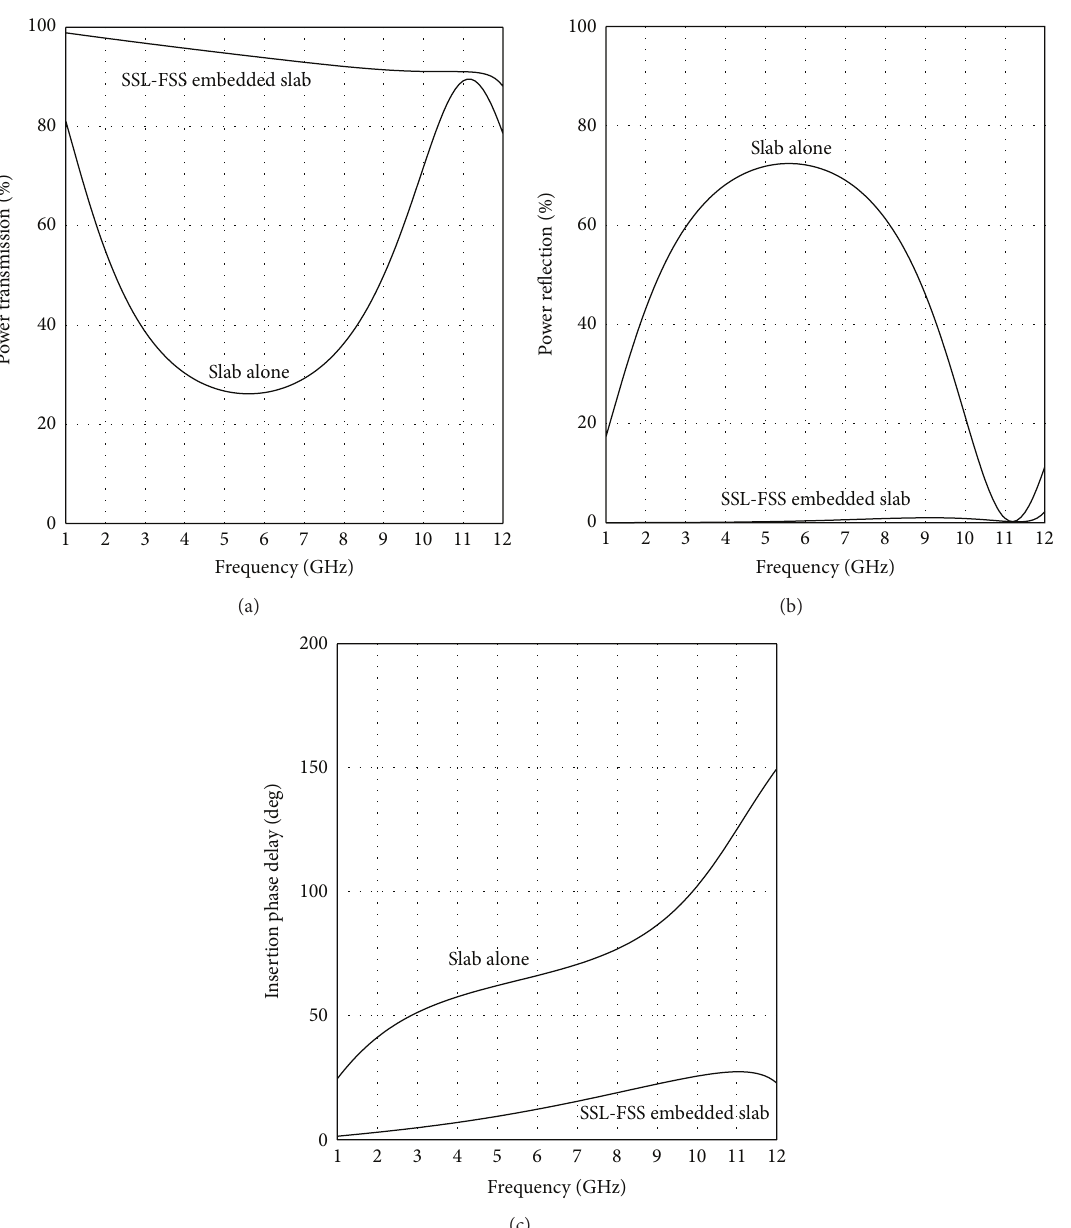
Figure 6: (a) SSL-FSS embedded monolithic half-wave slab design results in higher power transmission characteristics at 60 ∘ over a broadband (1GHz–12 GHz) as compared to the slab alone case. (b) SSL-FSS embedded monolithic half-wave slab design results in lower power reflection characteristics at 60 ∘ over a broadband (1GHz–12 GHz) as compared to the slab alone case. (c) SSL-FSS embedded monolithic half-wave slab design results in superior insertion phase delay characteristics at 60 ∘ over a broadband (1GHz–12 GHz) as compared to the slab alone